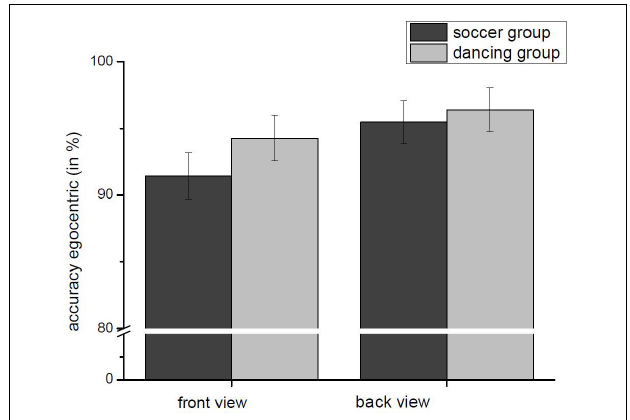
FIGURE 5 | Accuracy (Mean and SE) dependent on group and view for the egocentric transformation. No significant differences between soccer-players and dancers for front and back view stimuli for egocentric